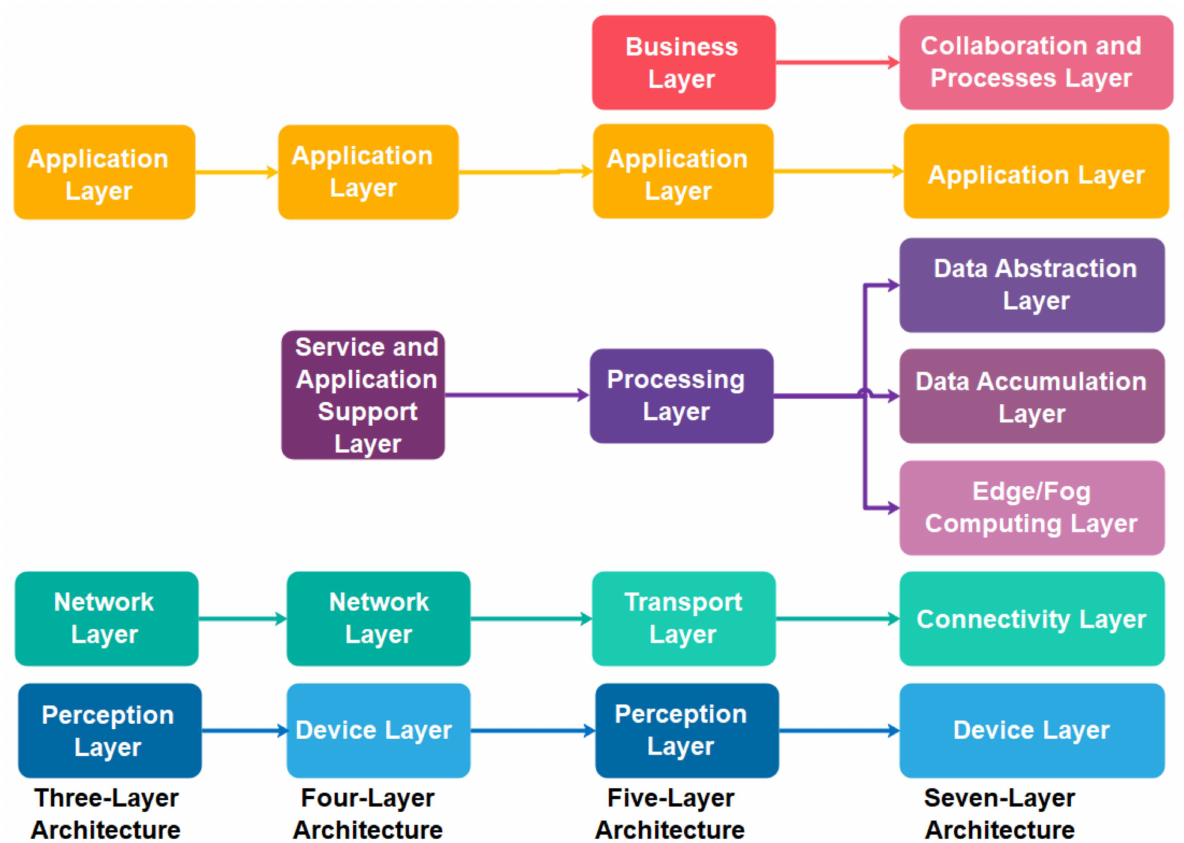
Figure 1. The relationship and mapping of three-layer, four-layer, five-layer and seven-layer IIoT